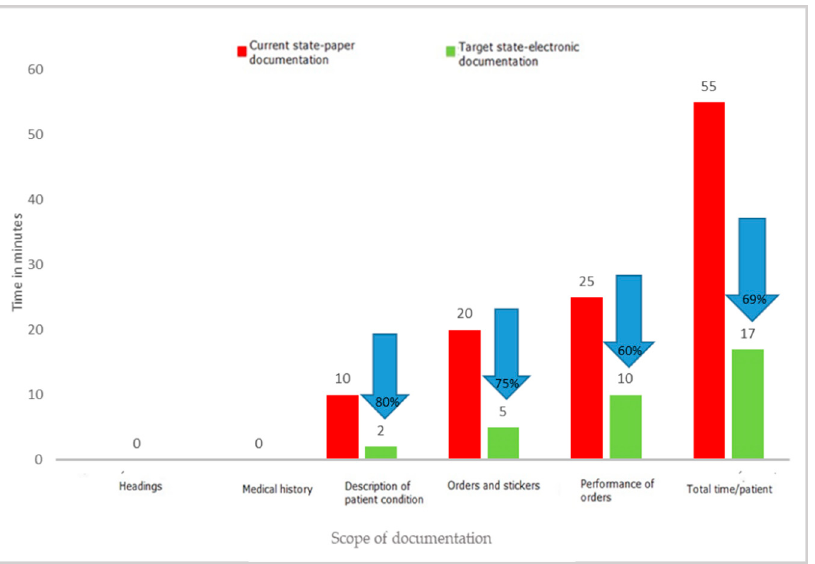
Figure 10. Time to complete the patient’s nursing documentation in the ward. Source: Own study based on the hospital materials.